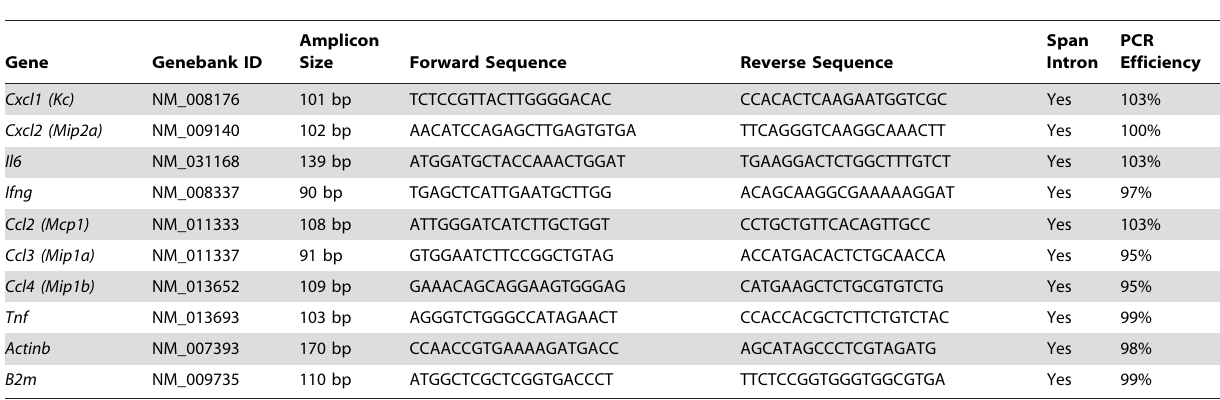
Table 1. Primer sequences used for real-time RT-qPCR.